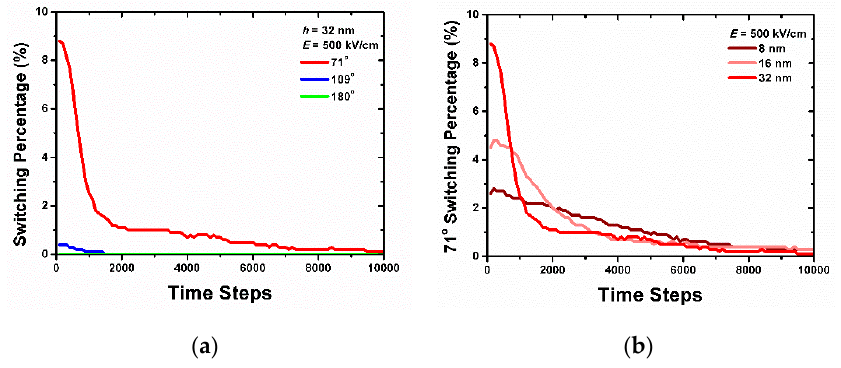
Figure 2. Analysis of domain switching behavior for different film thicknesses using an identical electric field: E = 500 kV/cm. ( a ) Switching percentage of different switching paths as a function of time in the h = 32 nm film. ( b ) Percentage for 71 degree switching over time, with different film thicknesses indicated with different colors.